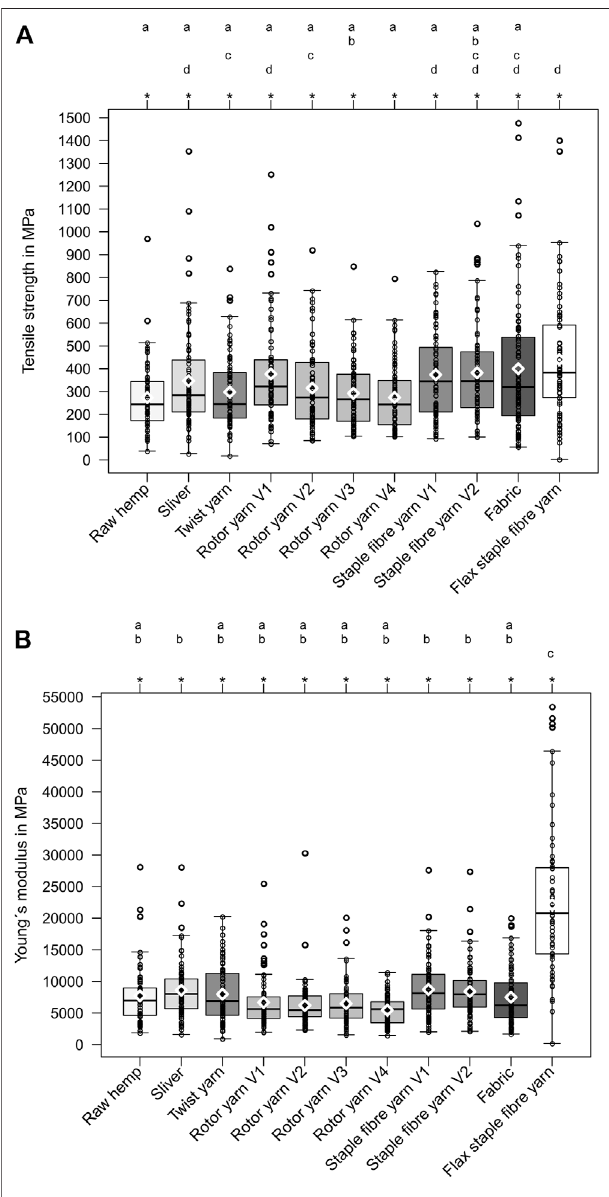
FIGURE 3 | Box-Whisker plots of the tensile strength (A) and Young´s modulus (B) of hemp fi bre bundles prepared from different processing stages compared to fl ax with mean value as rhombus (results which do not follow a normal distribution are marked with *, signi fi cant differences are indicated with different